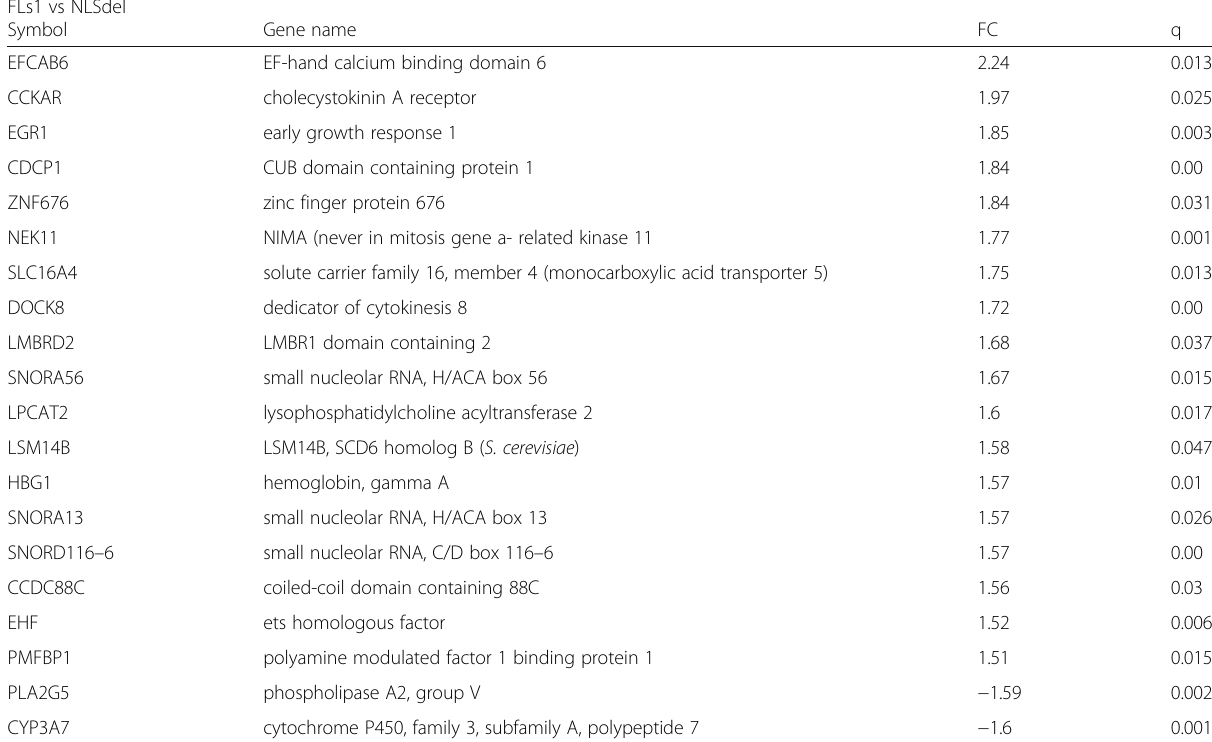
Table 1 Differentially expressed genes in cells with nuclear syndecan-1 (FLs1) versus cells with syndecan-1 lacking the NLS signal (NLSdel) FLs1 vs NLSdel Symbol Gene